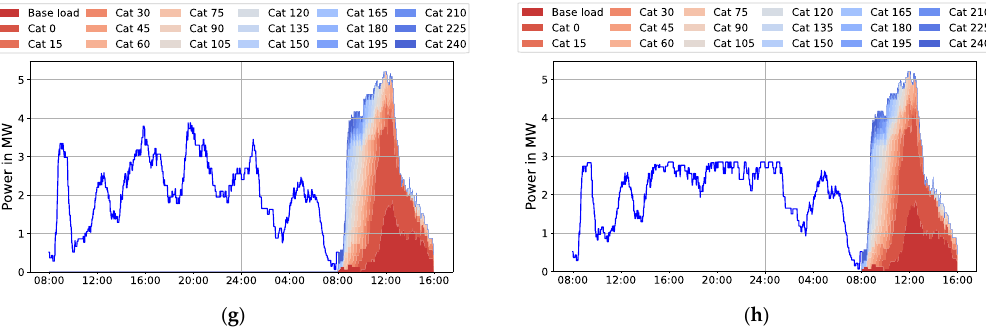
Figure A1. Calculated flexibility for BD2 from the perspective of 20:00 h and 24:00 h as well as 04:00 h and 08:00 h on the following day. The diagrams on the left side ( a , c , e , g ) represent the uncontrolled charging and the diagrams on the right side ( b , d , f , h ) represent controlled charging.